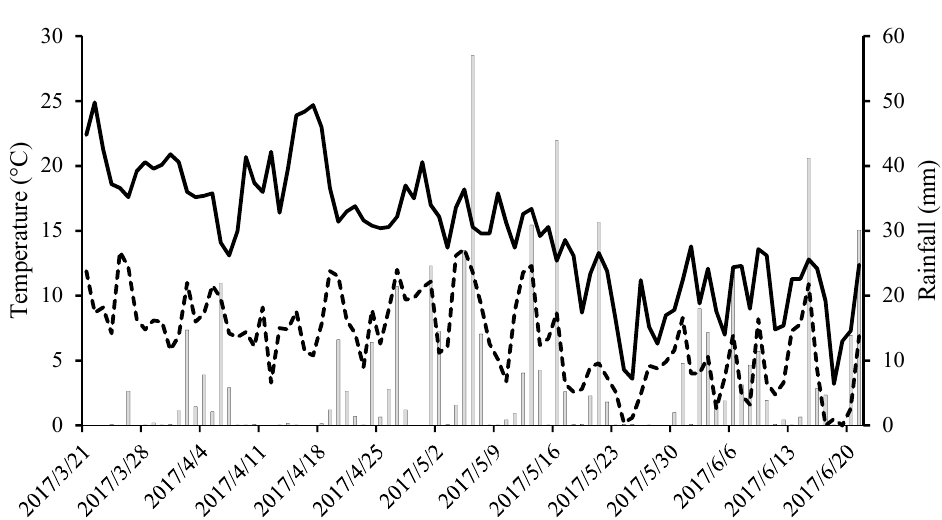
Figure 1. Daily maximum (solid line) and minimum (dashed line) temperature and rainfall (bars) for Valdivia, Chile, during the fall of 2017.